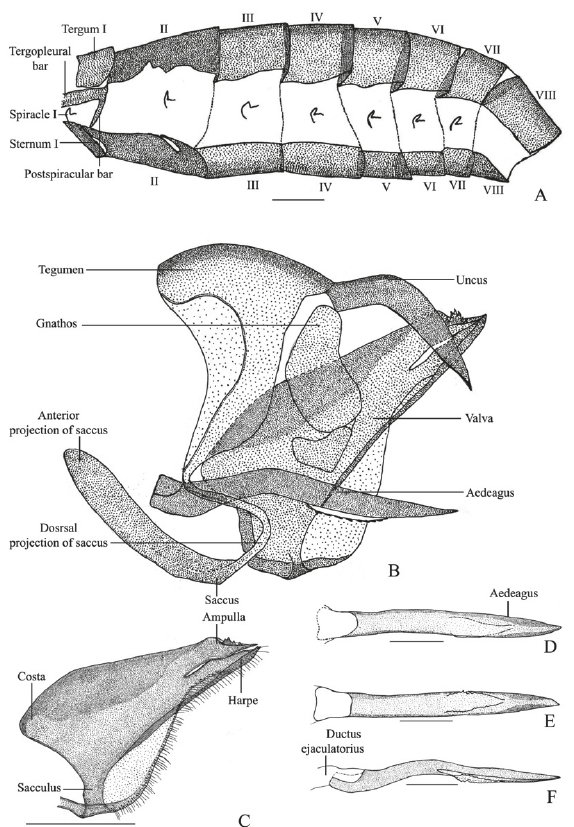
Figure 17. Male genitalia of Junonia atlites (Linnaeus, 1763) A - abdomen (lateral view); B - male genitalia (lateral view); C - right valva (inner view); D – F - aedeagus (dorsal, ventral and lateral view respectively). Scale bar 1mm.